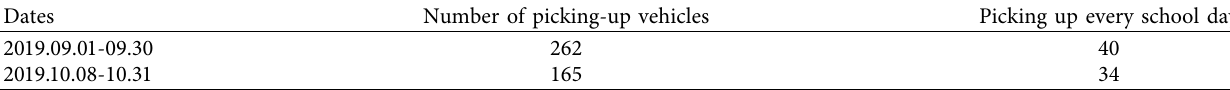
Table 3: High-frequency vehicles on the case road from September 1 to October